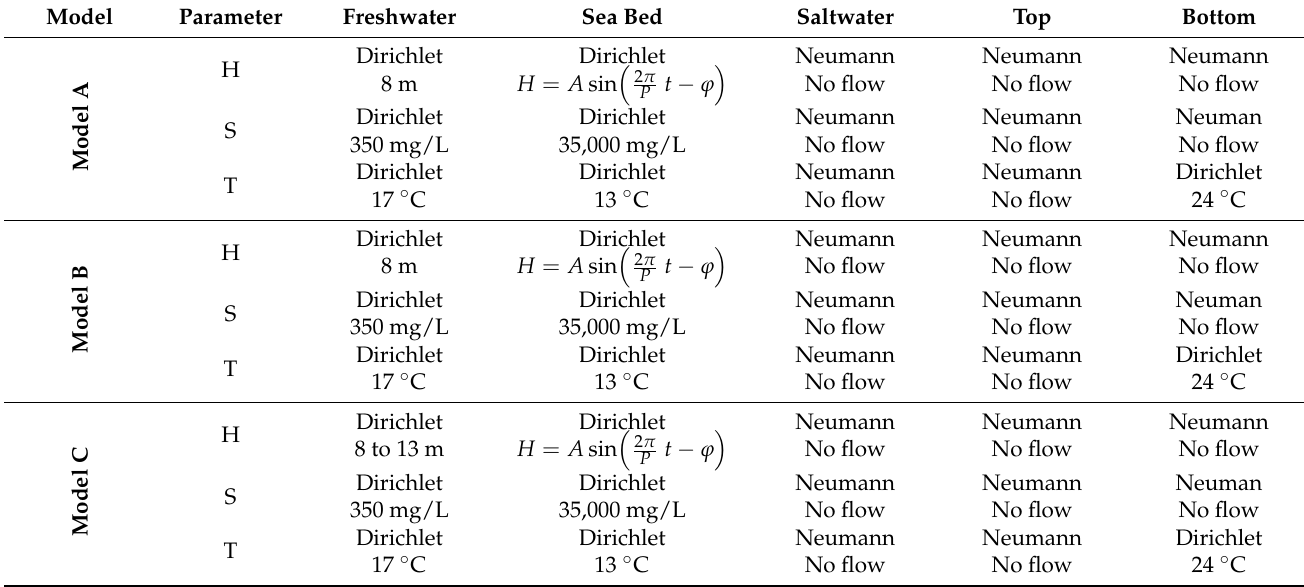
Table 1. Values of hydraulic head (H), salinity (S) and temperature (T) given to each boundary of the models A, B and C.